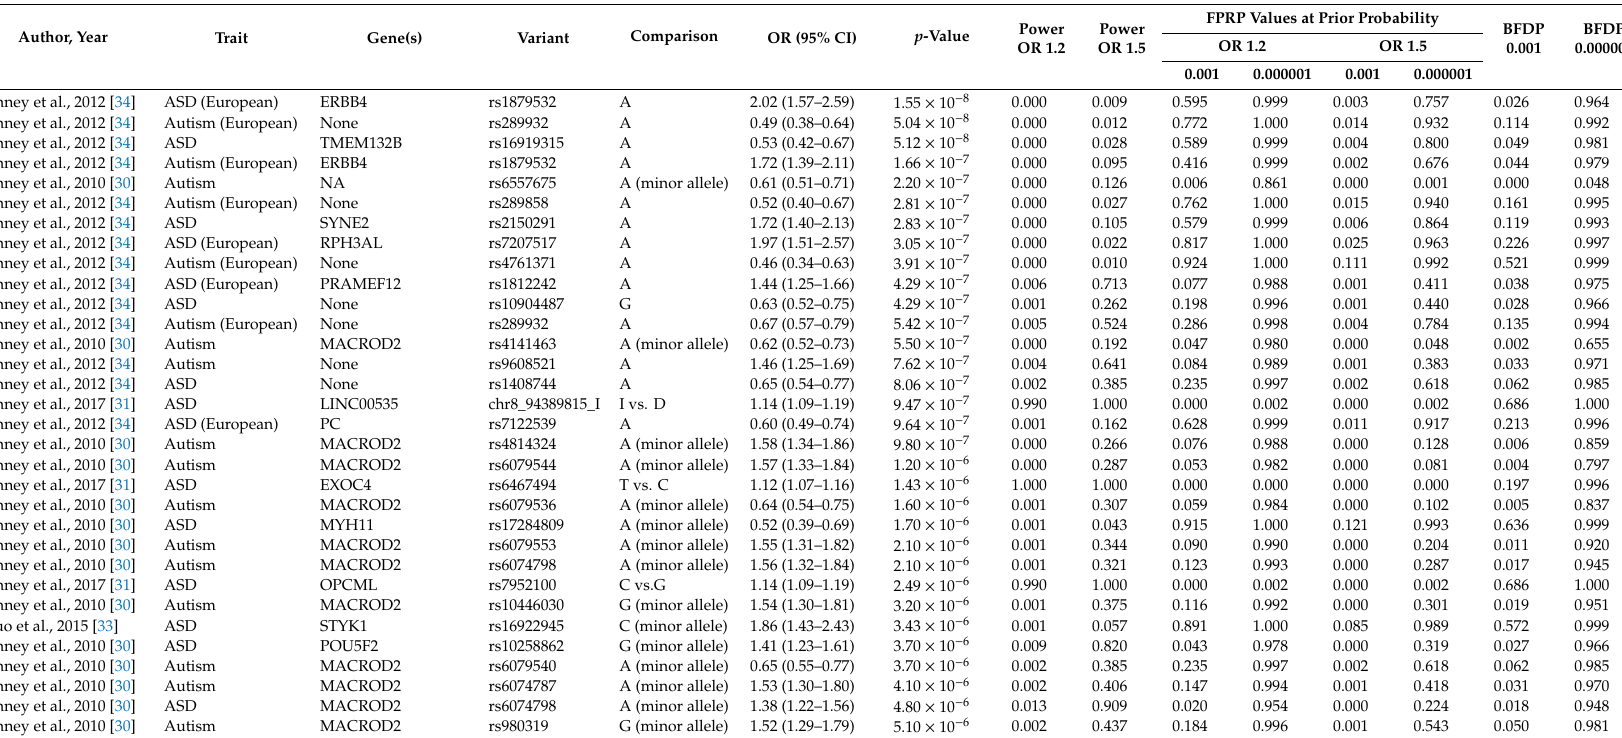
Table 4. Re-analysis results of gene variants with genome wide statistical significance ( p -value < 5 × 10 − 8 ) and borderline statistical significance (5 × 10 − 8 ≤ p -value